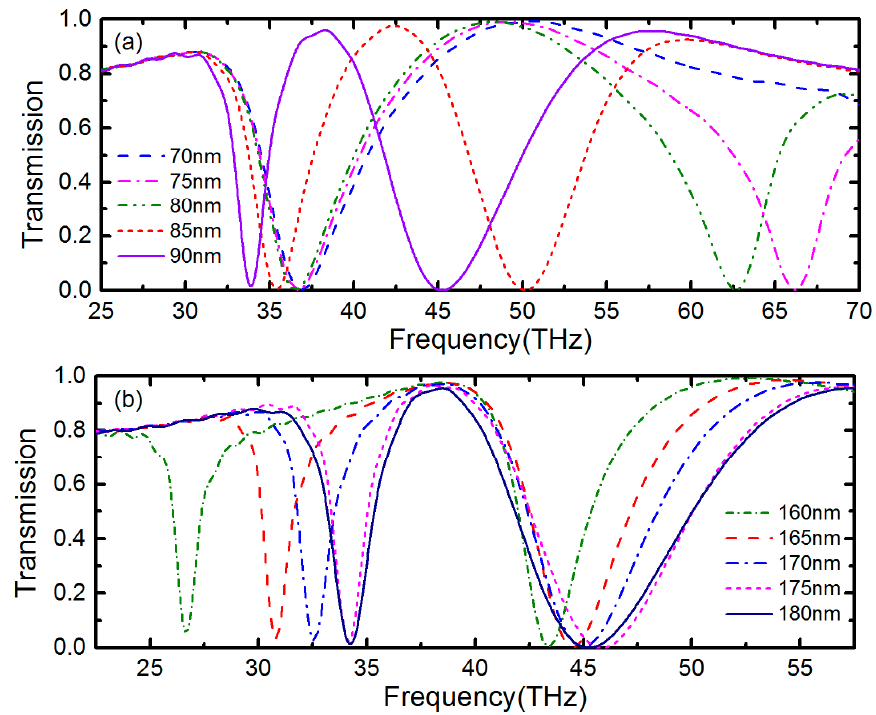
Figure 6. Transmission spectrum for ( a ) different inner radii of IR and ( b ) different outer radii of OR with other geometrical parameters unchanged.